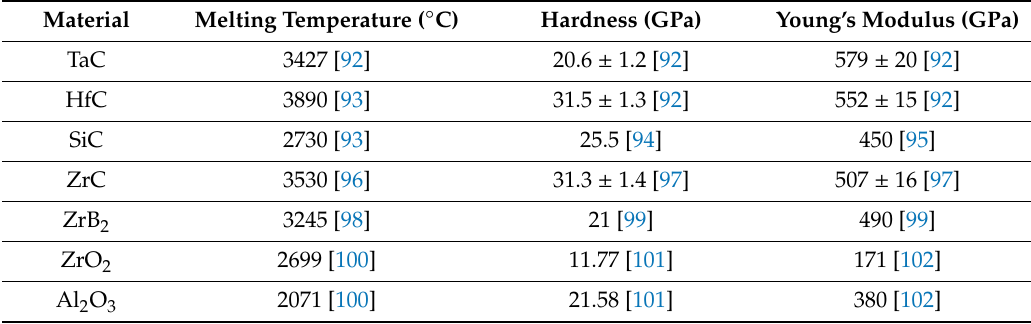
Table 1. Melting temperature and mechanical properties of various materials used as thermal barrier